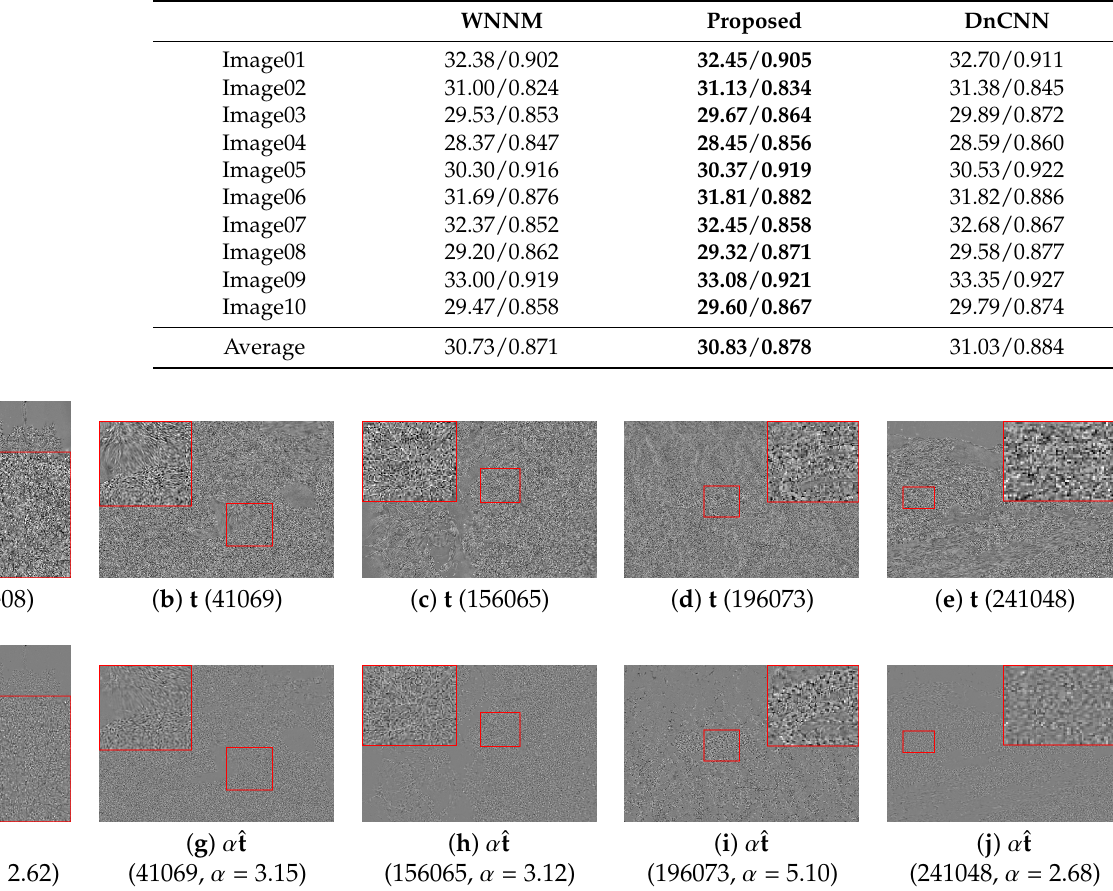
Table 6. Comparison of non-learning-based methods (WNNM and the proposed method) and a learning-based method (DnCNN). The PSNR [dB] and SSIM results obtained after denoising on dataset I (with a noise standard deviation of 𝜎 = 15). Note that the proposed method does not require any training and is fully explainable. The bold value means the highest PSNR or SSIM in